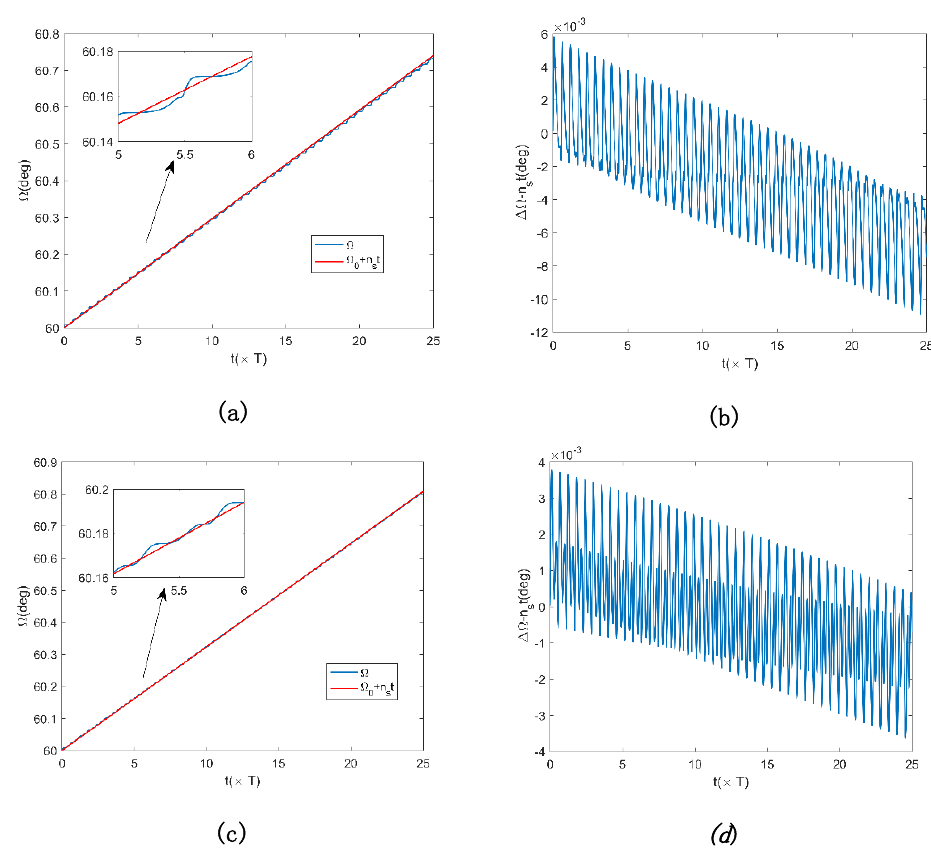
ΔΩ = Ω − Ω and n t over 25 T , where T Figure 5. Evolution of Ω and difference between ∆Ω = Ω − Ω 0 and n s t over 25 T , where T is a Figure 5. Evolution of Ω and difference between s 0 Jovian day, Ω 0 = 60 deg is the initial condition (the blue curve was indeed obtained by numerical 60 Ω = deg is the initial condition (the blue curve was indeed obtained by nu- is a Jovian day, 0 integration of osculating elements). ( a ) Evolution of Ω for a = 102755.451 km, i = 90.183 deg. merical integration of osculating elements). ( a ) Evolution of Ω for ( b ) Difference between ∆Ω and n s t for a = 102,755.451 km, e = 0.4, i = 90.183 deg. ( c ) Evolution of for a = 109,439.953 km, e = 0.1, i = 90.321 deg. ( d ) Difference between ∆Ω and n s t for a = 109,439.953 km, e = 0.1, i = 90.321 ference between ΔΩ and